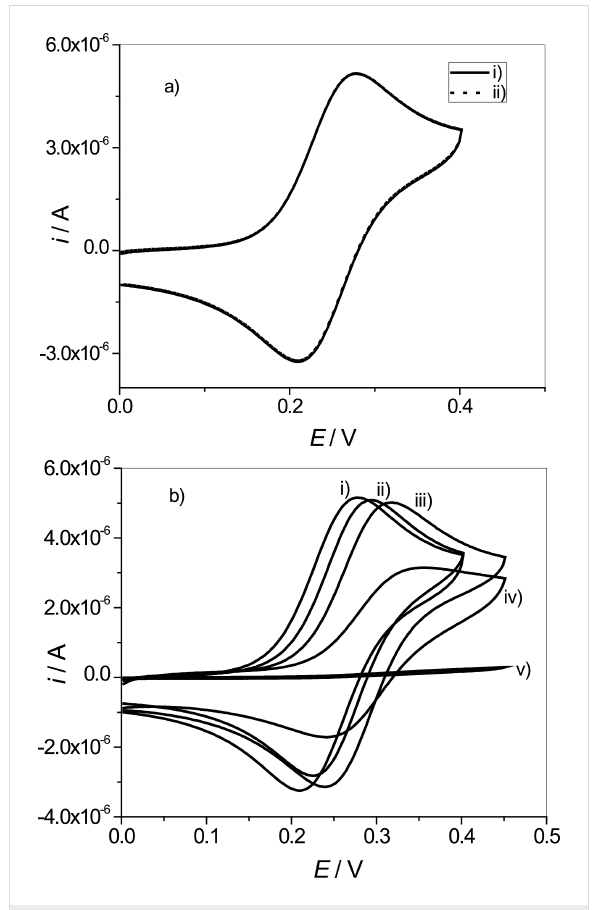
Figure 5: Cyclic voltammograms of K 4 [Fe(CN) 6 ] in phosphate buffer solution (pH 7.0) using a) (i) bare AuE , (ii) AuE previously immersed in a solution of DOPC LUVs for 30 min, washed and taken to the electro- chemical cell. b) Cyclic voltammograms of K 4 Fe(CN) 6 in phosphate buffer solution (pH 7.0) by using AuE previously immersed in different SH–DOPC LUV solutions for 30 min, washed and taken to the electrochemical cell. The following SH/DOPC molar ratios were used: i) bare AuE ii) 0.003:1; iii) 0.033:1; iv) 0.33:1 and v) 0.66:1 ( = 1 × 10 − 3 M; v = 100 mV·s − 1